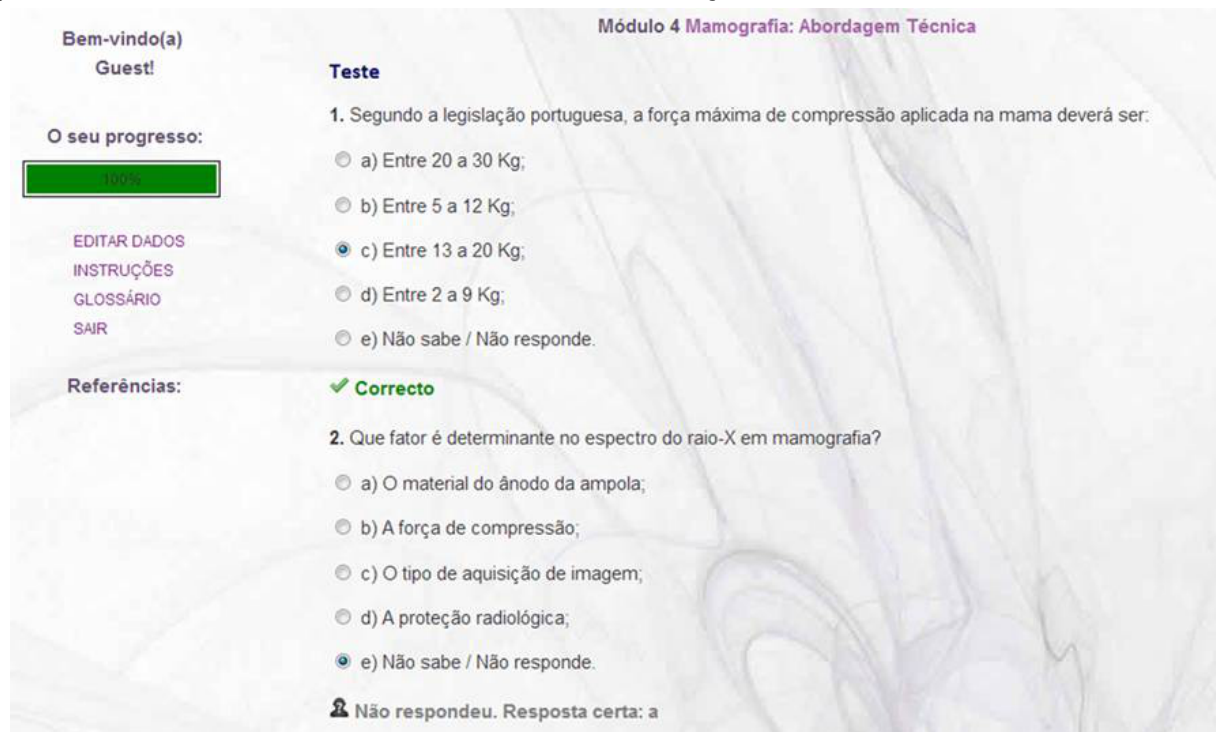
Figure 5. Screenshot of one of the four self-assessment tests included in the e-learning